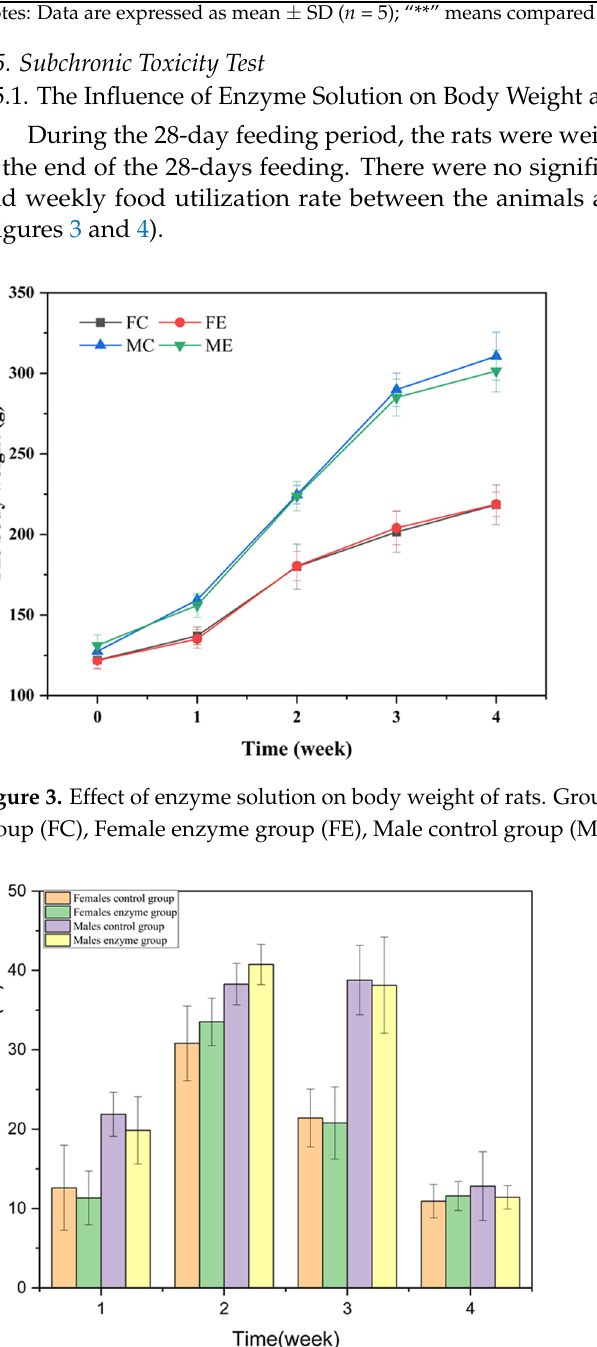
Table 2. Effect of enzyme solution on the incidence of sperm malformation in mice.